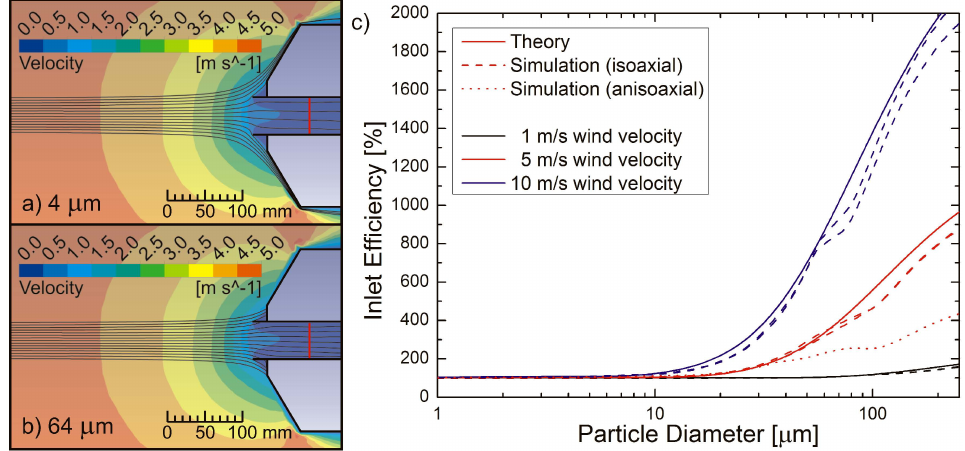
Fig. 3. Simulations of the HOLIMOII inlet. Particle sampling for (a) 4µm and (b) 64µm diameter spheres was simulated in a 5ms − 1 ambient wind field. The detection plane is indicated by a red line in (a) and (b) . In both cases, wind deceleration begins 20cm ahead of the inlet tip. Due to inertia, the larger particles in (b) deviate from the air flow around the inlet and become enriched in the sample volume. The (c) simulated (dashed lines, multiple runs) and theoretical (solid lines, Paik and Vincent, 2002; Liu et al., 1989) results are compared for three different wind velocities. An additional simulation (red dotted line) is shown for anisoaxial sampling of 15 ◦ for a wind velocity 5ms − 1